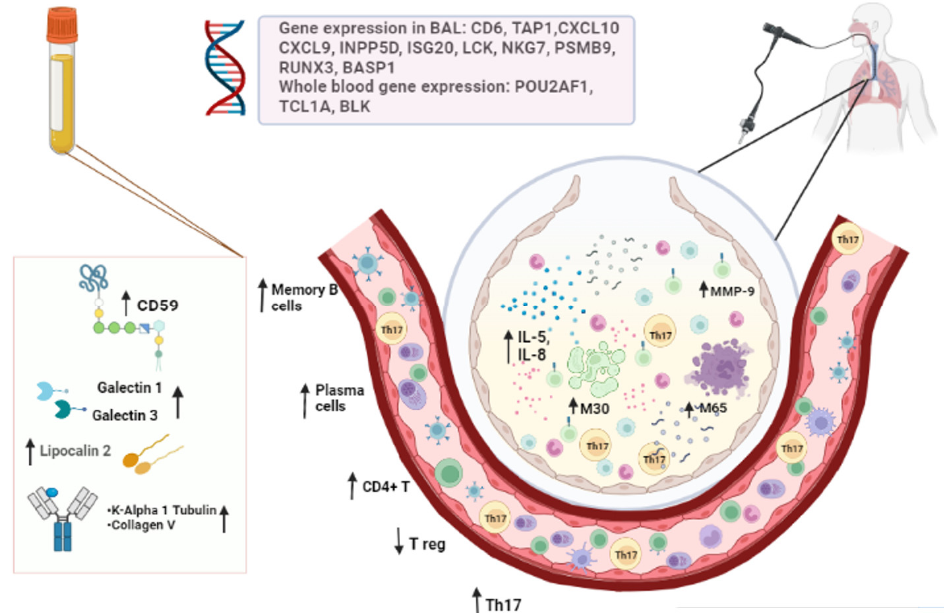
Figure 2. The most relevant circulating biomarkers and gene expression.